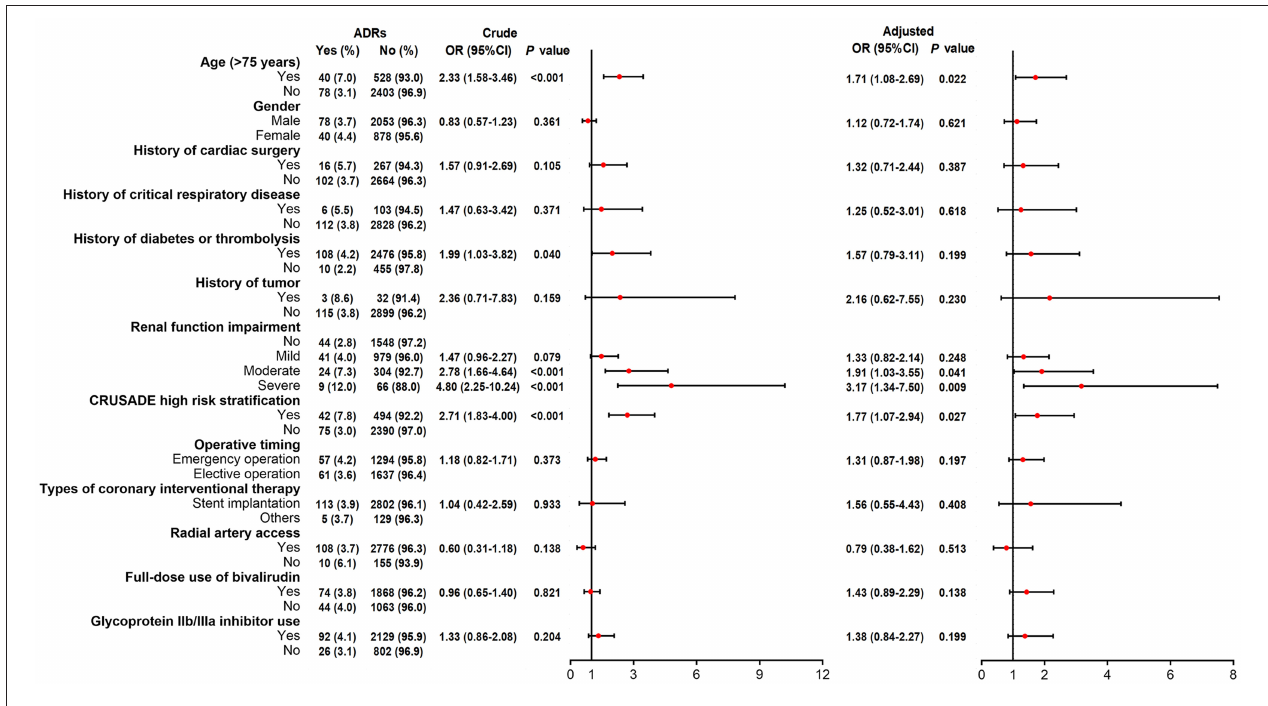
FIGURE 1 | Logistic regression analyses for factors related to ADRs risk.